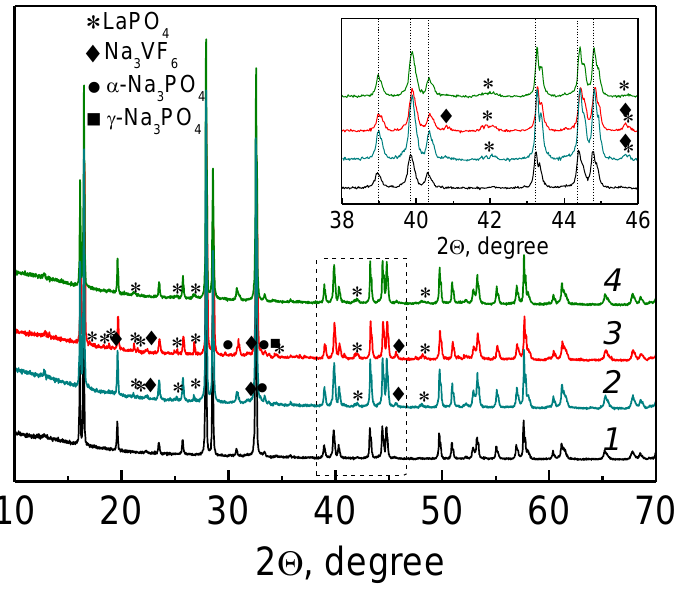
Figure 1. XRD patterns of the pristine NVPF (1) and the products obtained upon La 3+ modification: NVPF-La02 (2), NVPF-La05 (3), NVPF/LPO (4).